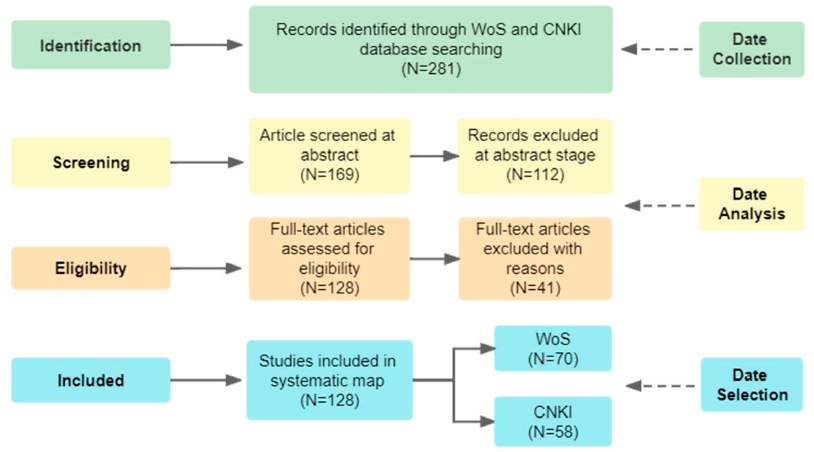
Figure 3. Data selection process.